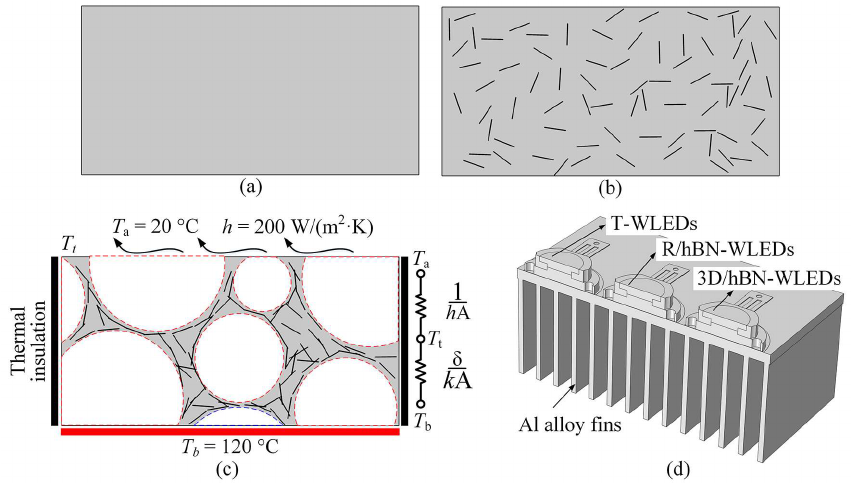
Figure 3. ( a – c ) Schematics showing the physical model and boundary conditions of T-composite, R/hBN-composite, and 3D/hBN-composite, respectively. ( d ) Schematic showing the thermal simu- lation models of these WLEDs.